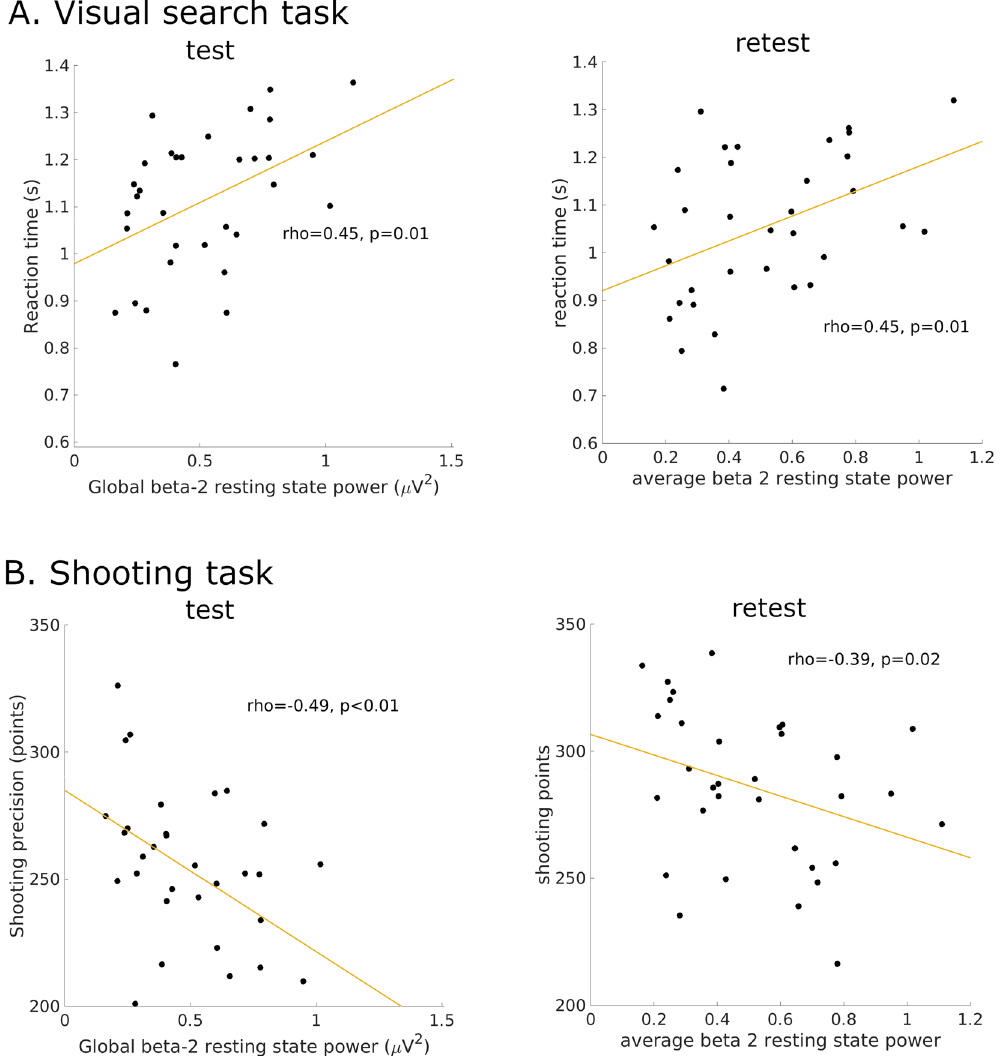
Figure 1. Correlations between average global beta-2 power (22–29 Hz) in the resting state (gB2rest) and behavioral performance. ( A ) Reaction times in the visual search task, n = 33. ( B ) Scores from target shooting (out of a possible 400), n =